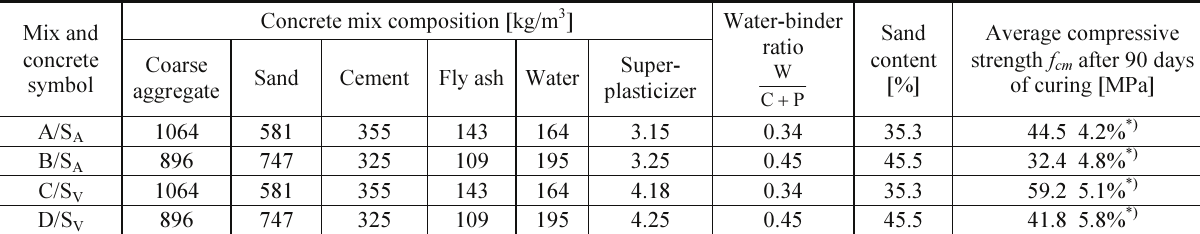
Table 2. Determined rheological properties of concrete mixes Test